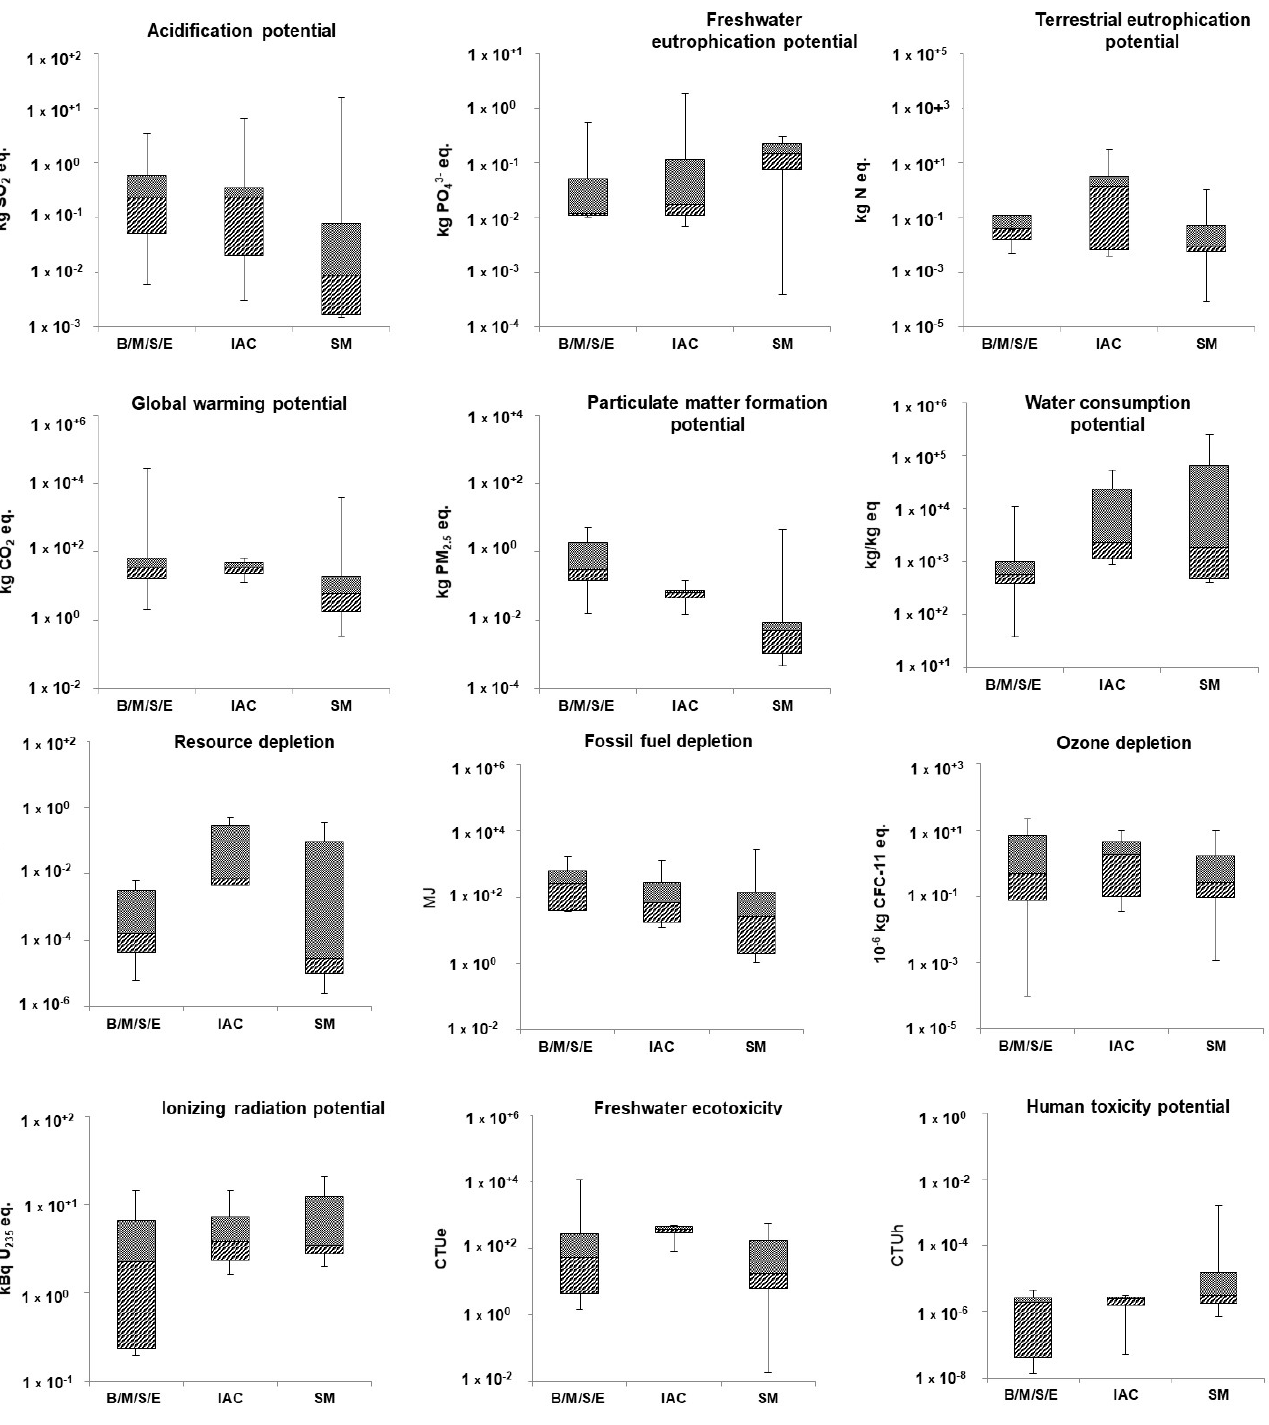
Figure 3. Comparison of the different impacts between primary (B/M/S/E and IAC) and secondary source materials (SM) for REE production.